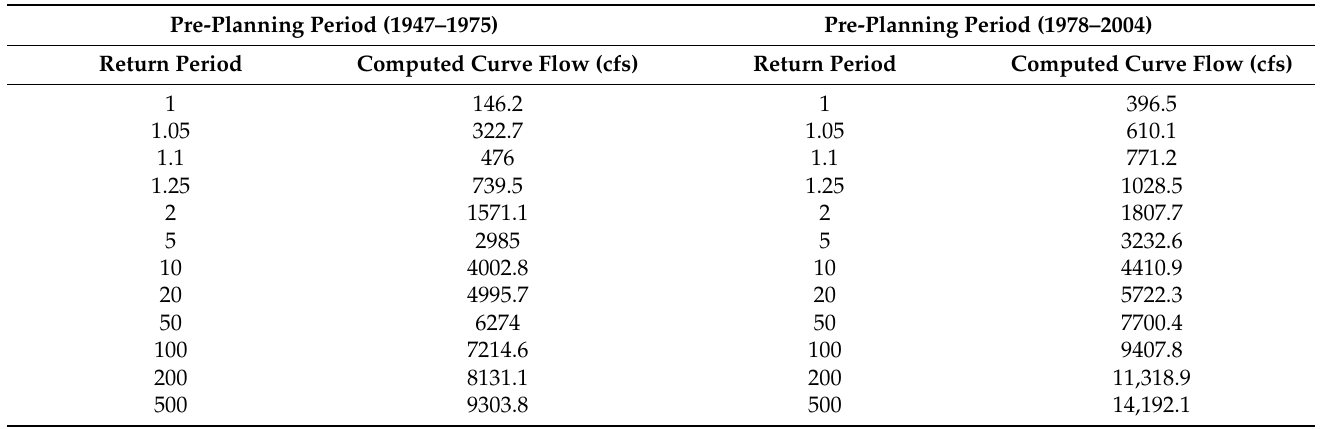
Table A2. Return periods and their corresponding computed curve flows for the two halves of the pre-planning period.